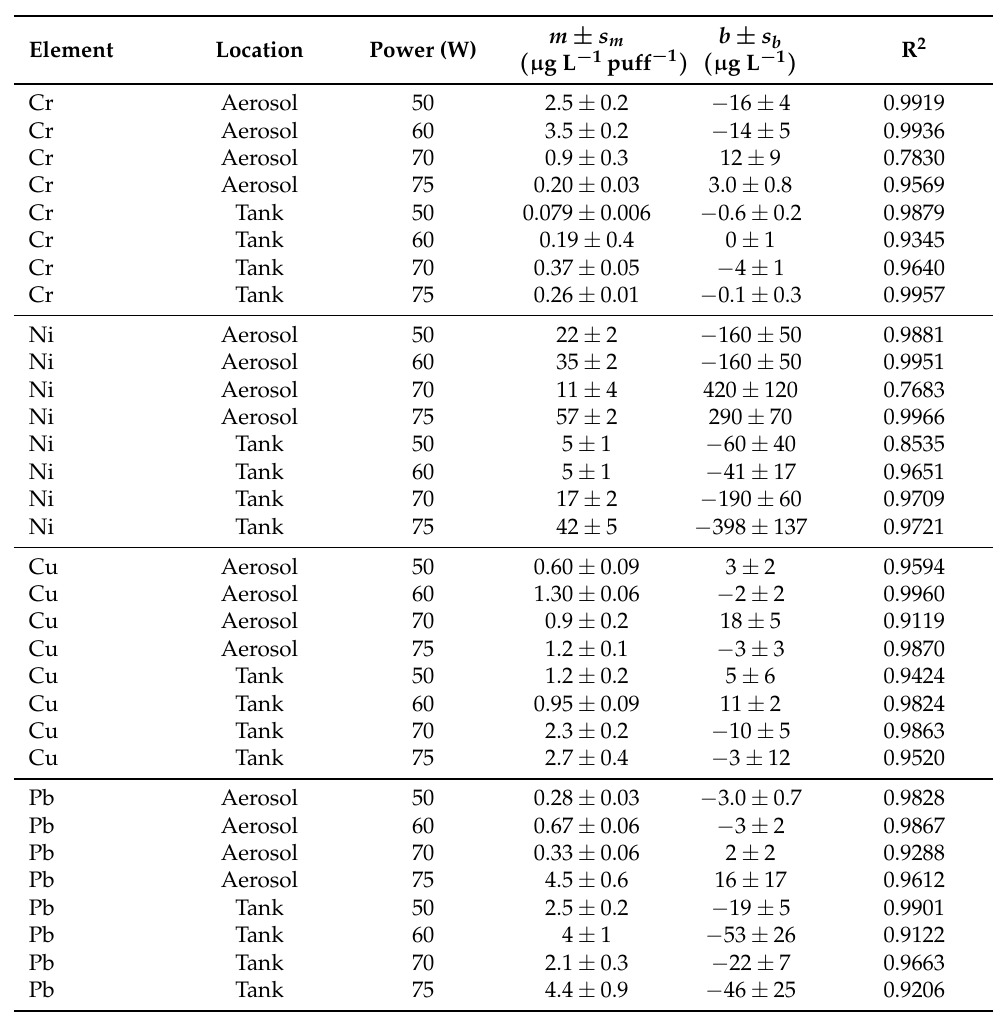
Table 1. Fit parameters for linear fits of concentration vs. number of puffs. Slope ( m ) and intercept ( b ) are provided with standard deviations of the fits. The slope represents the average rate of increase in concentration per